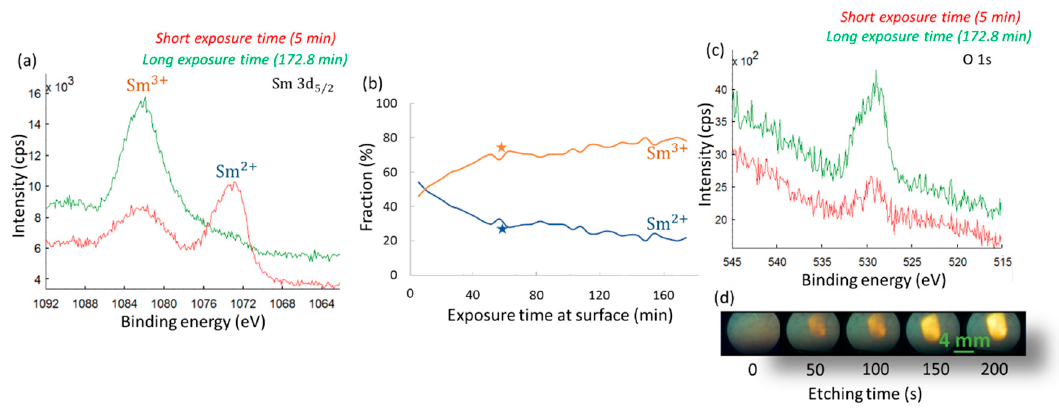
Figure 7. XPS analysis of a 100 nm thick SmS thin film. ( a ) Sm 3d 5/2 photoelectron peak. The red curve corresponds to a short exposure time to x-rays of 5 min. Green curve corresponds to the longest measured exposure time of 172.8 min. ( b ) Fraction of Sm 2+ and Sm 3+ as a function of exposure time at the surface. X-rays remained on during the entire measurement. Orange and blue stars show the derived Sm 3+ and Sm 2+ percentages, after 1h surface exposure under vacuum conditions, with the x-rays off. ( c ) O 1s photoelectron peak. Same measurement conditions as in a). ( d ) Photographs taken by a microscope in the XPS set-up demonstrate the color change of the thin film surface, as the sputtering time increases from 0 to 200 s.